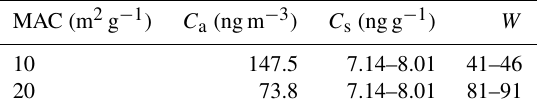
Table 1. Values used for the calculation of rBC scavenging ratios ( W ) at Jungfraujoch, Switzerland. For air concentration ( C a ), the eBC average value of 24 June was used under two different MACs. For snow concentration ( C s ), concentrations from the two sets of replicates were